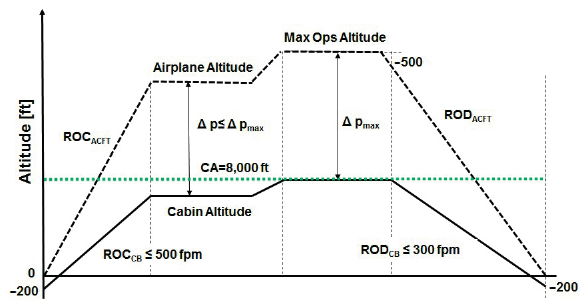
Fig. 1. Simplified aircraft and CA pressurization dynamics. Not to